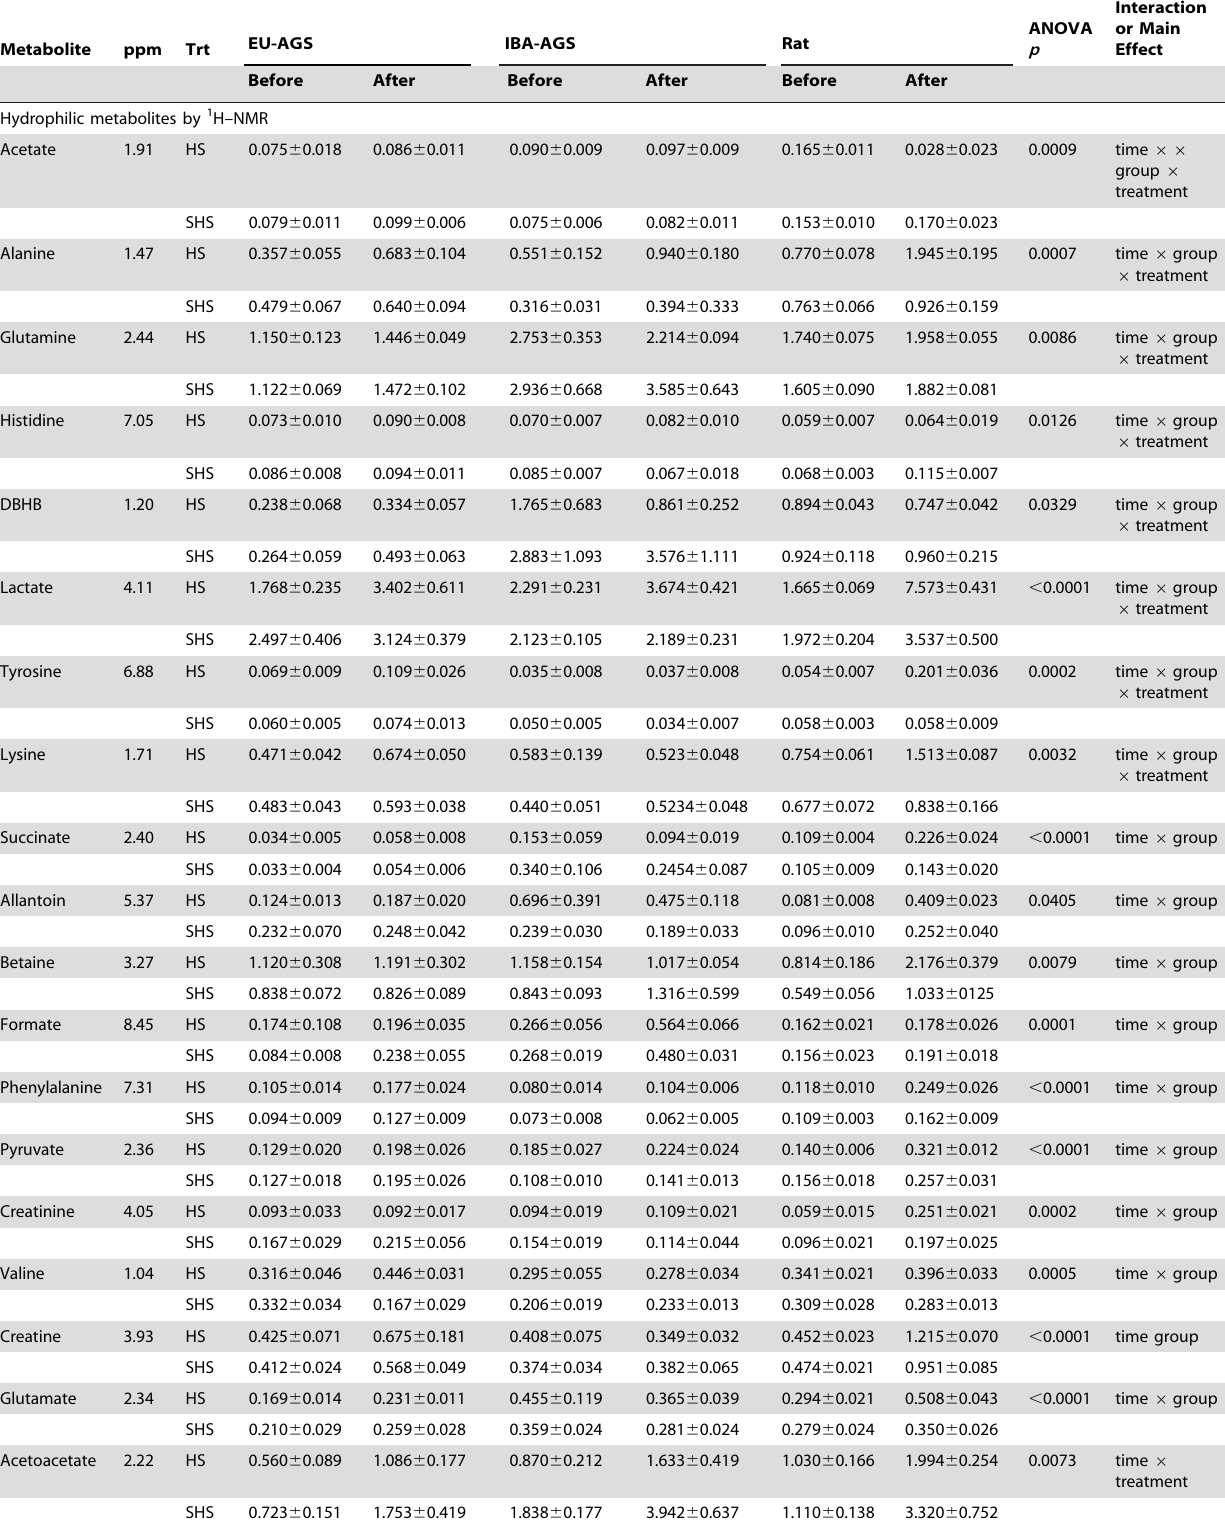
Table 2. Average concentrations (mM plasma) and SEM of metabolites for summer euthermic (EU) arctic ground squirrels, winter interbout arousal (IBA) arctic ground squirrels, and rats immediately before and three hours after hemorrhagic shock (HS) or sham